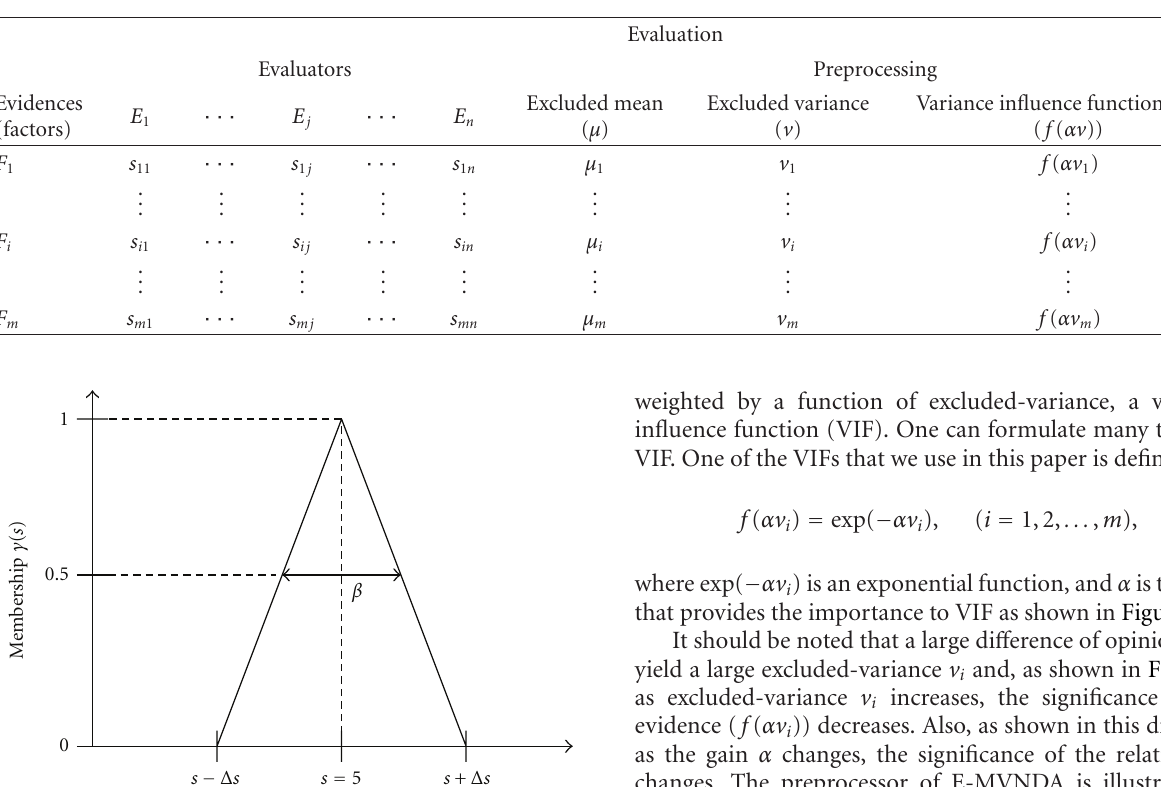
Table 1: Evaluation matrix ( m × n ) and preprocessing for E-MVNDA. ( m = number of evidences; n = number of evaluators.)